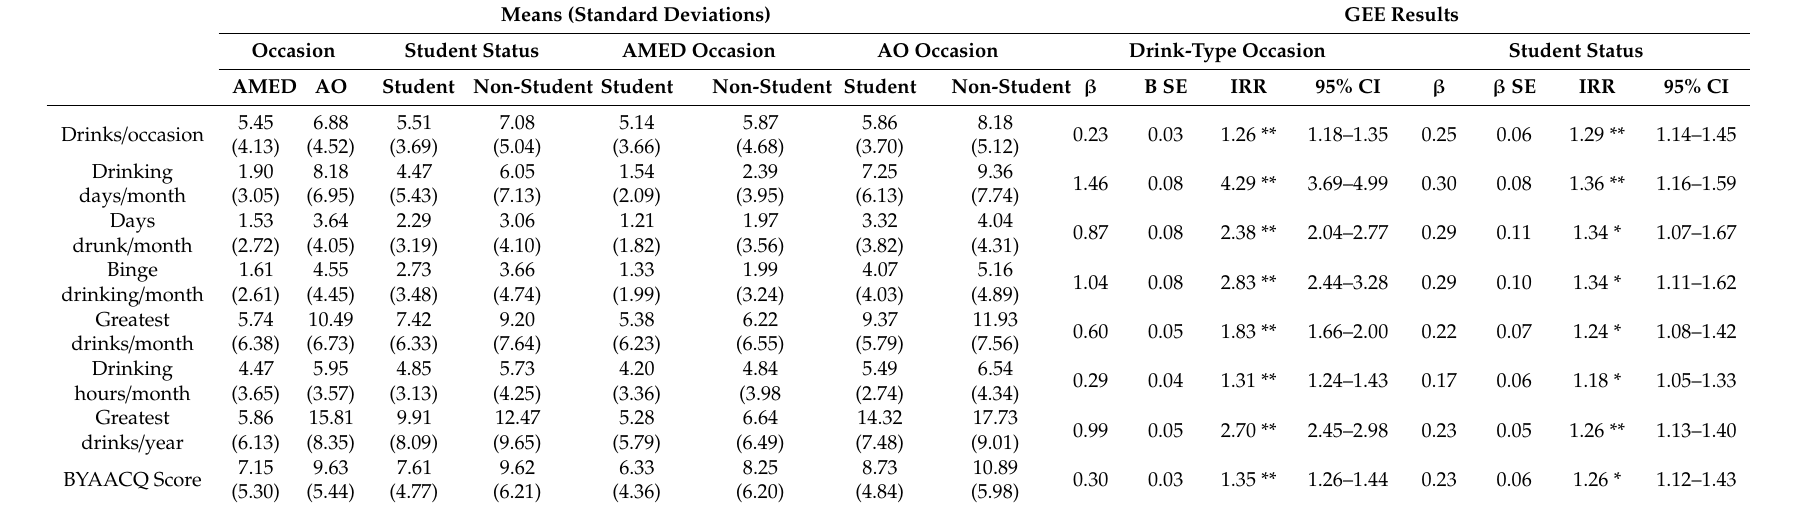
Table 4. Within-subjects comparisons of the AMED group according to drink-type occasion and student